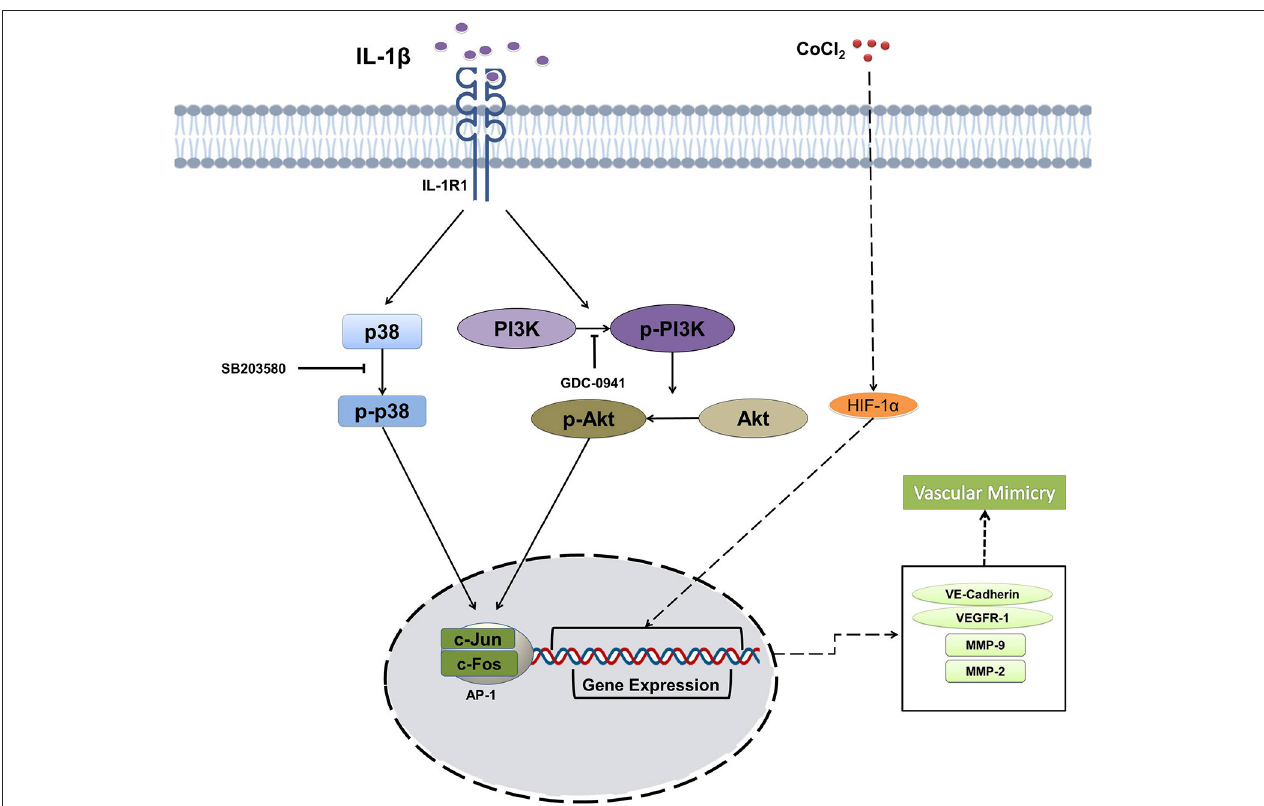
FIGURE 7 | Schematic illustration summarizing the effect of IL-1 β on the vasculogenic mimicry (VM) of breast cancer cells via p38/MAPK and PI3K/Akt signaling pathways. compared with normoxia, adding to the evidence that hypoxia also contributes to microvascular changes stimulated by IL-1 β